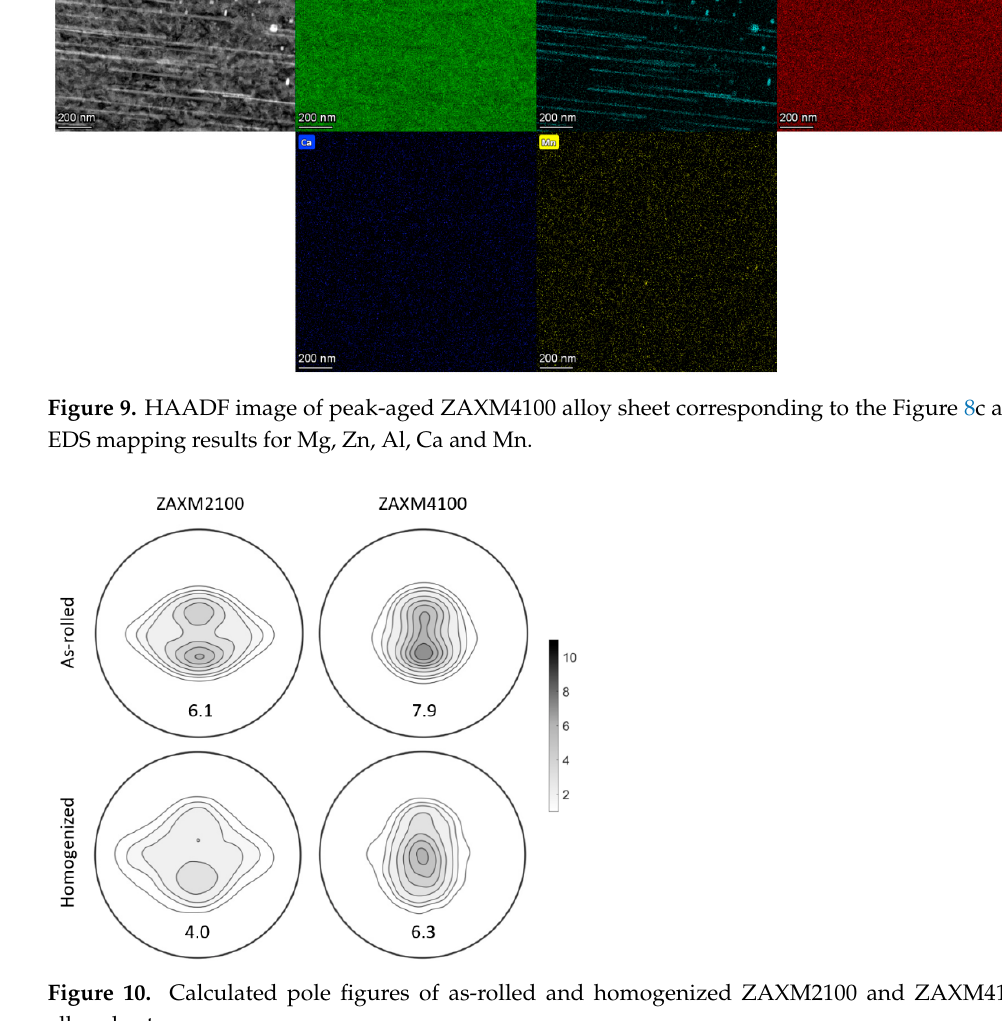
Figure 9. HAADF image of peak-aged ZAXM4100 alloy sheet corresponding to the Figure 8c and EDS mapping results for Mg, Zn, Al, Ca and Mn.